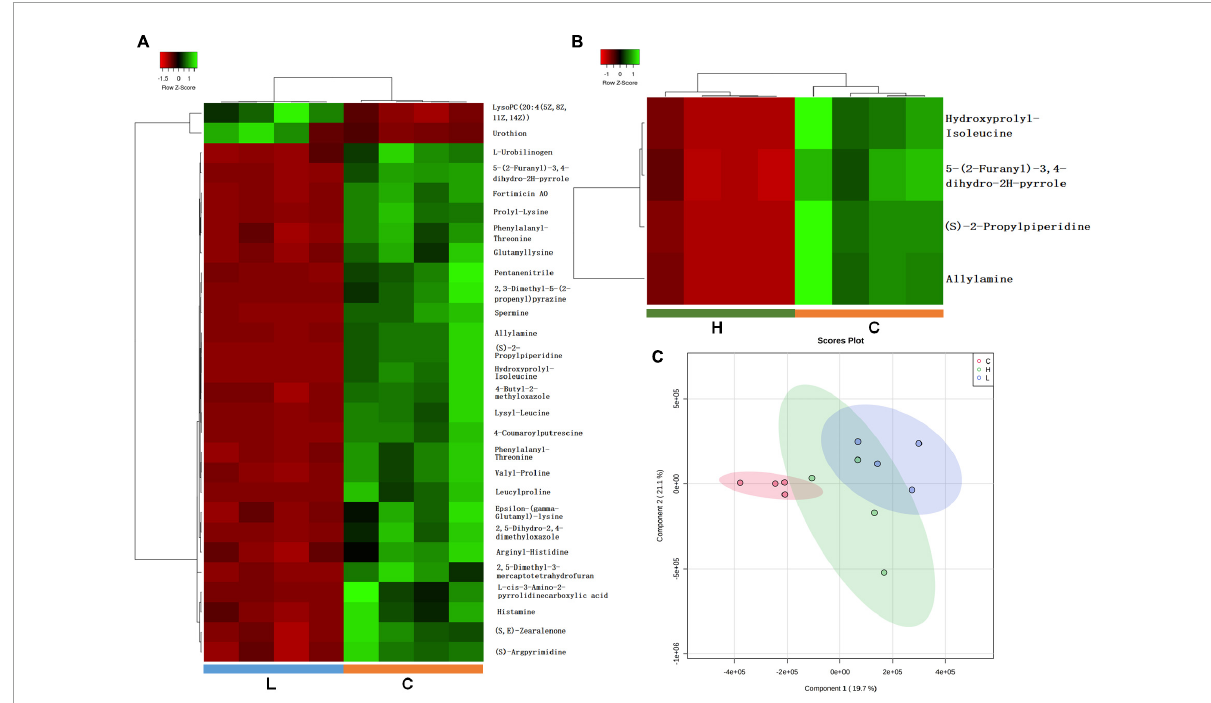
FIGURE5 Important discriminatory metabolites identified by clustering, correlation, and multivariate analysis in inflammation and CRC. (A) Hierarchical clustering analysis (HCA) for the significantly changed metabolites in inflammation. (B) Hierarchical clustering analysis (HCA) for significantly changed metabolites in CRC. (C) OPLS-DA analysis displaying the grouped discrimination of health, inflammation and CRC by the first two